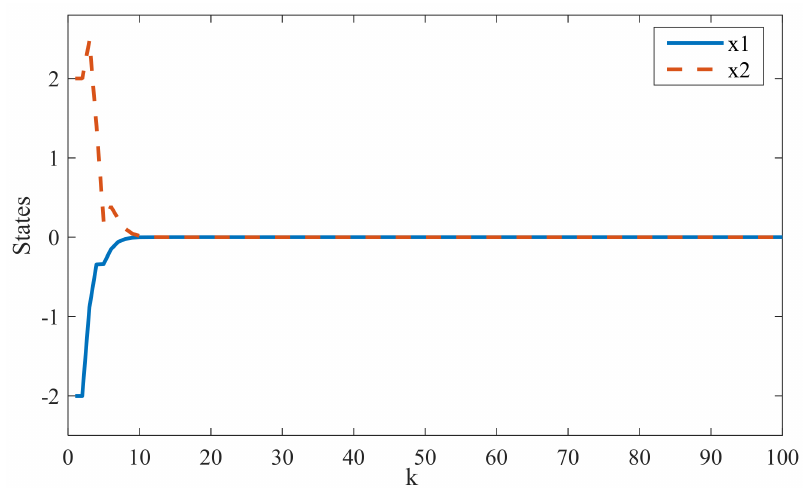
Figure 7. Performance of the co-design of the control and GMRS for the NCS with zero-order hold.